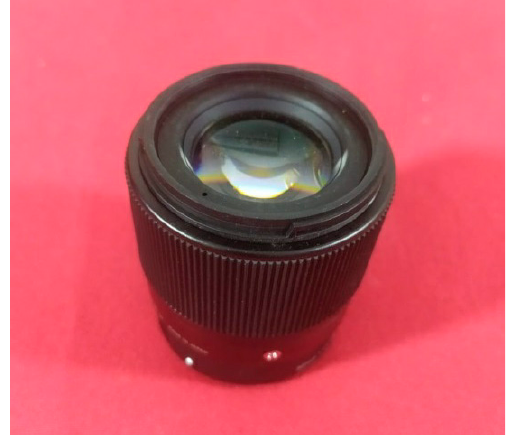
Figure 17. The low-light lens was used for the results.